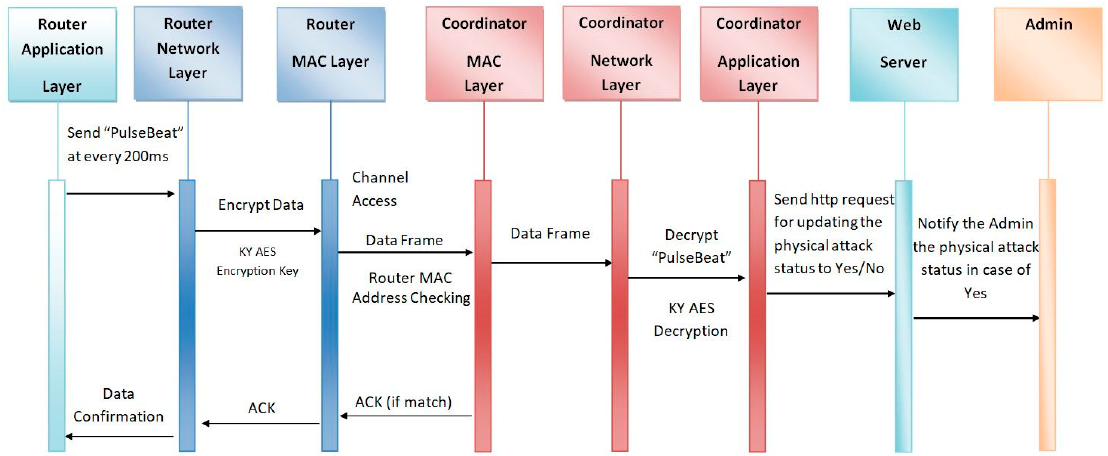
Figure 4. Sequence diagram of Router, Coordinator, Webserver, and Admin to detect Physical Attack in the proposed Security Improvement Framework (SIF).